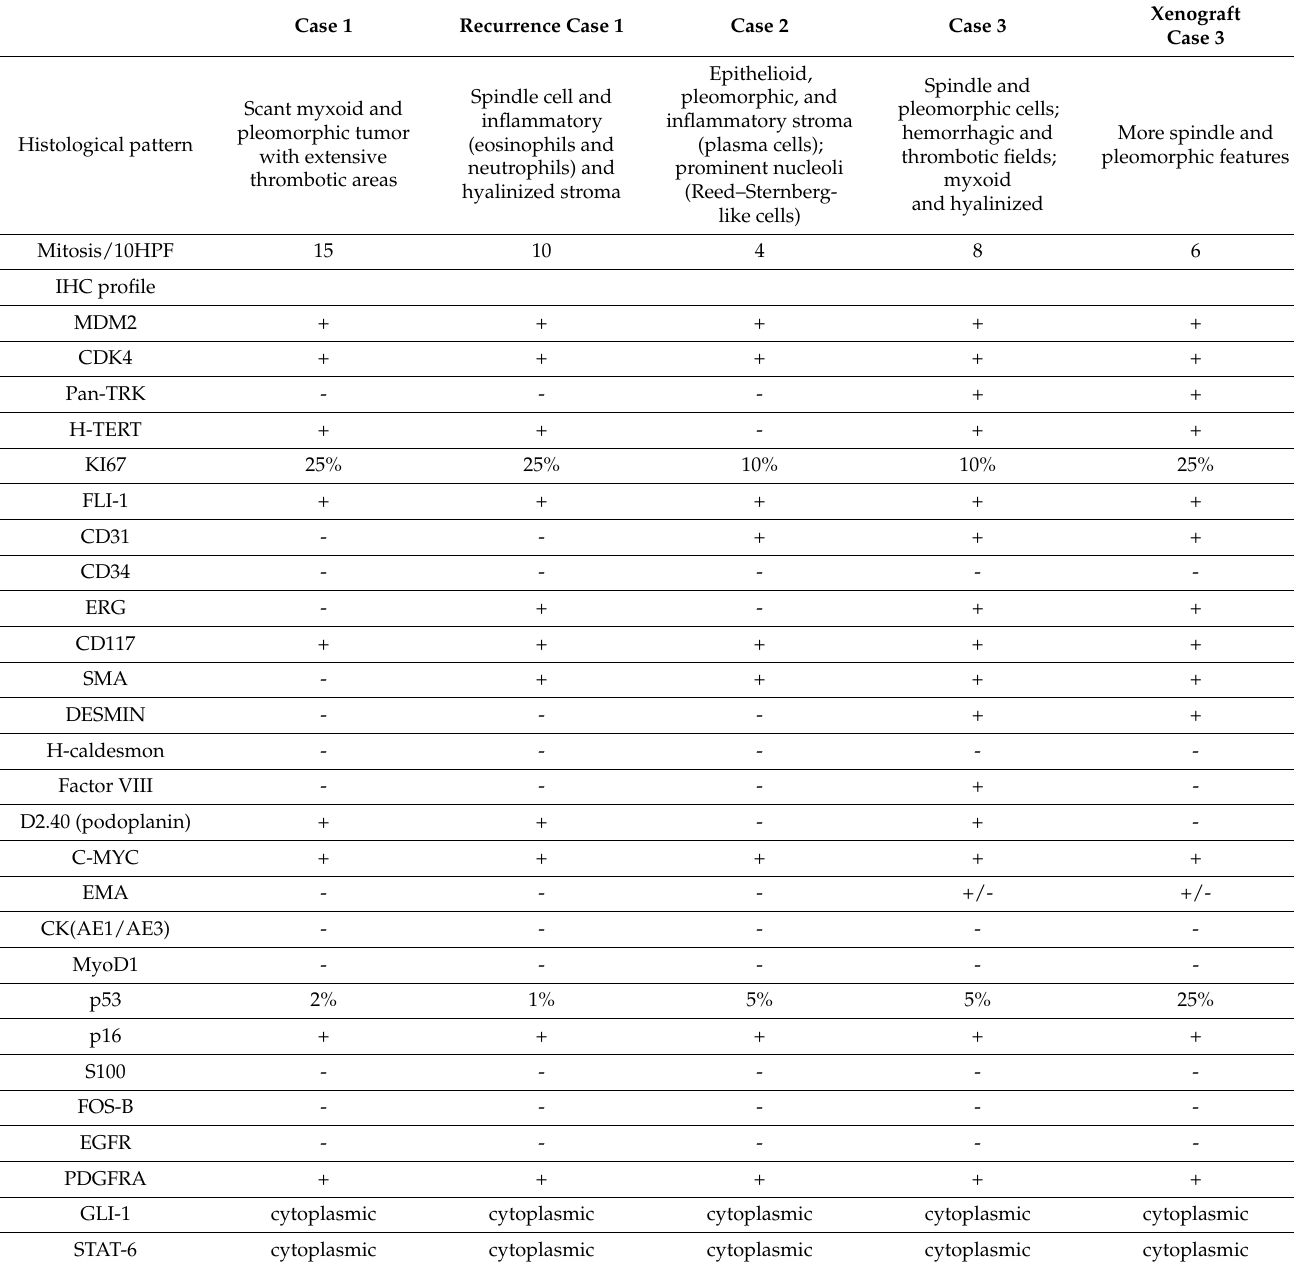
Table 2. Histopathological features and immunohistochemical profile of intimal sarcomas with xenografted